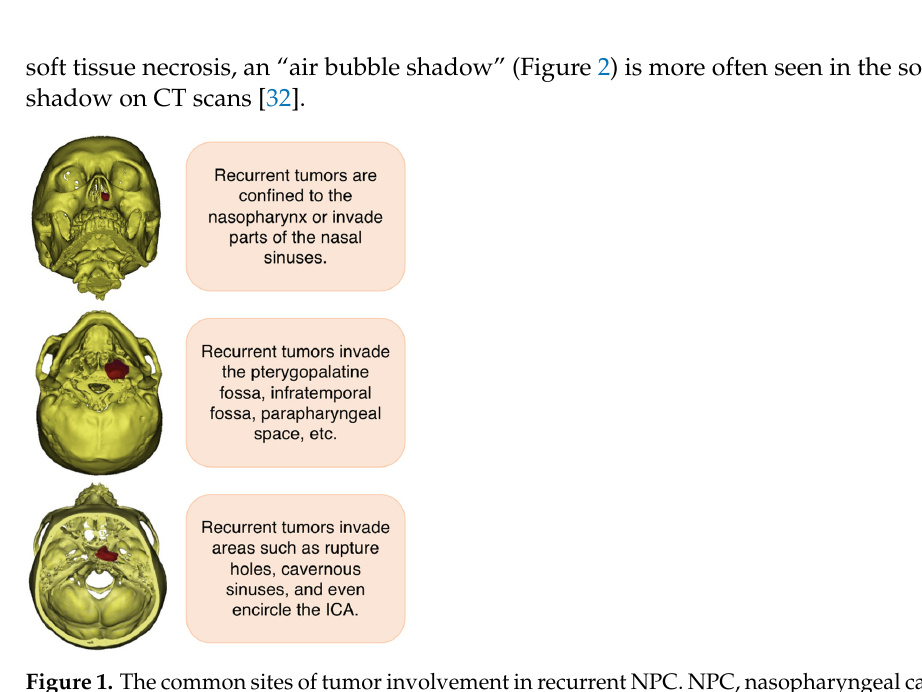
Figure 1. The common sites of tumor involvement in recurrent NPC. NPC, nasopharyngeal carcinoma; ICA, internal carotid artery.